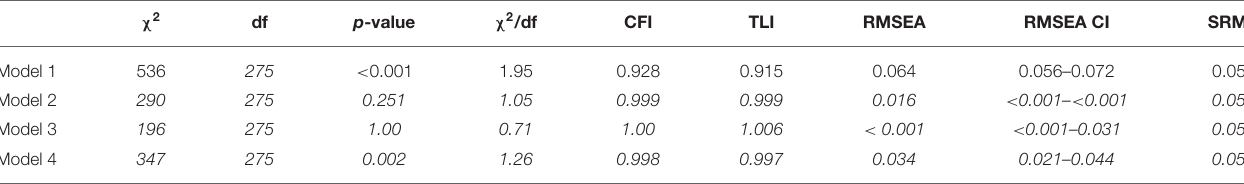
TABLE 2 | Fit of the measurement models.